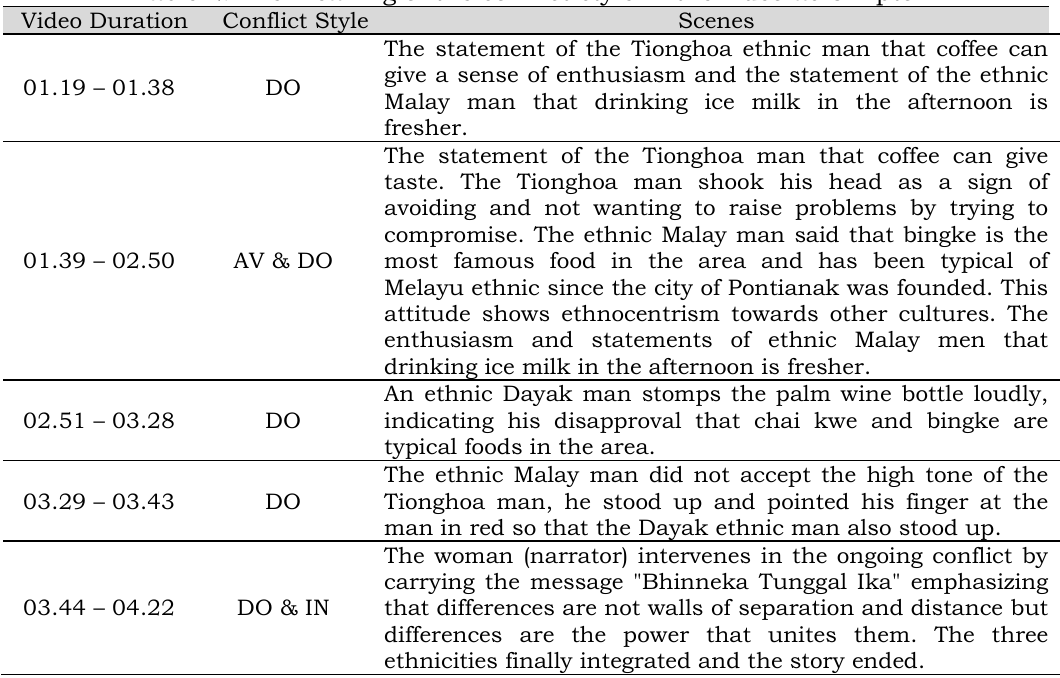
Table 2. The meaning of the conflict style in the video as Simpton Video Duration Conflict Style